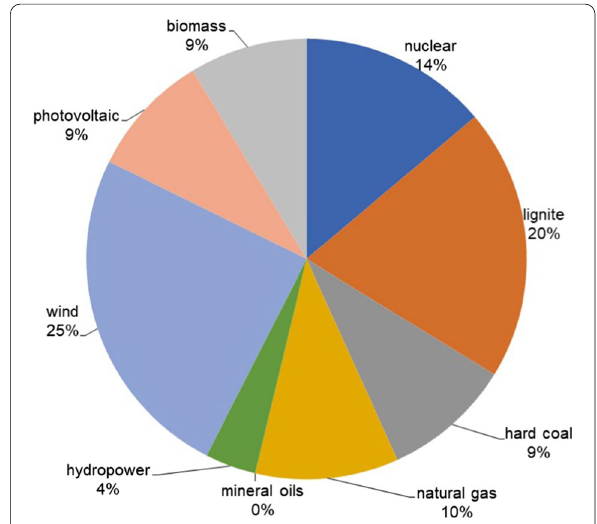
Fig. 3 Electricity Mix of Germany for 2019 [51]